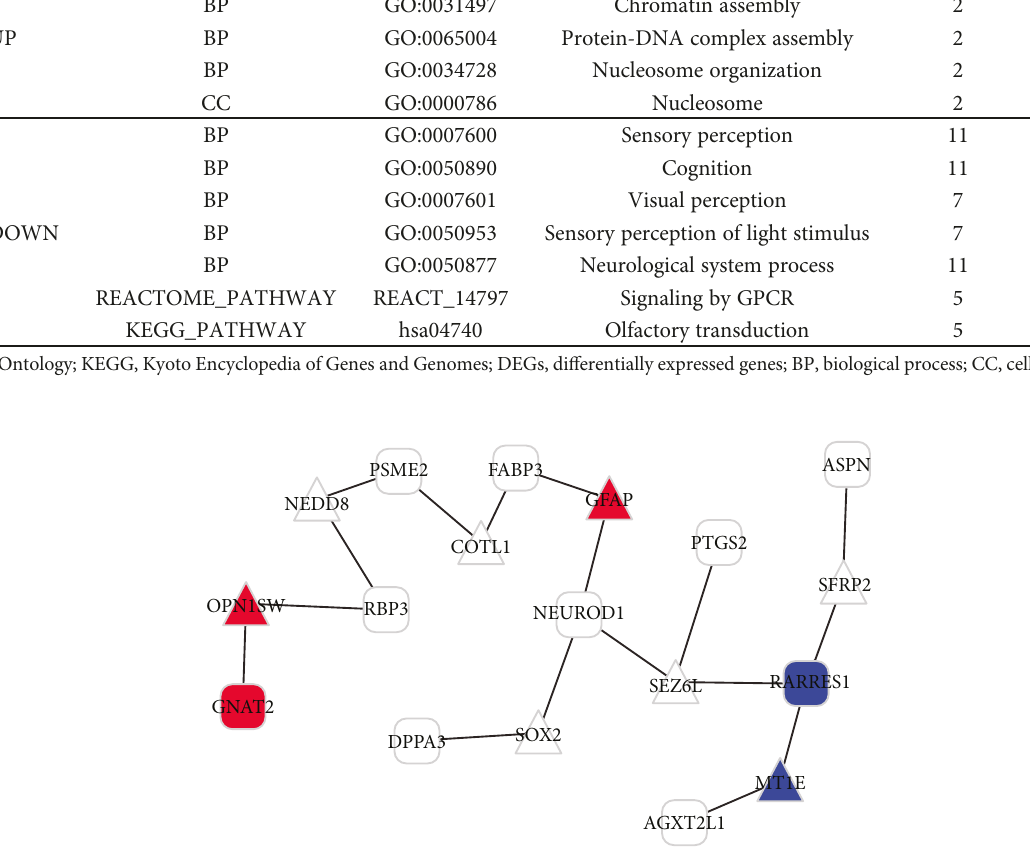
Figure 2: Di ff erentially expressed genes (DEG) interaction network. Squares represent inputted DEGs; triangles represent intermediate genes recorded in BioPro fi ling.de; red nodes represent disease-related genes; blue nodes represent carcinoma-related